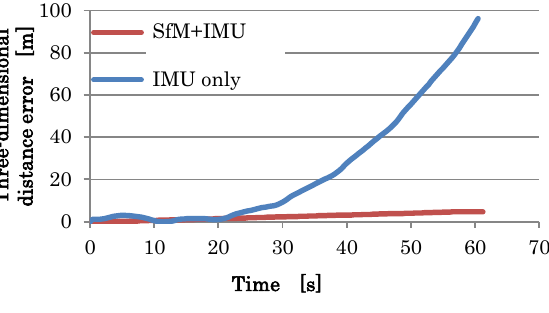
Fig. 17 Accuracy comparison using exterior orientation elements of the camera